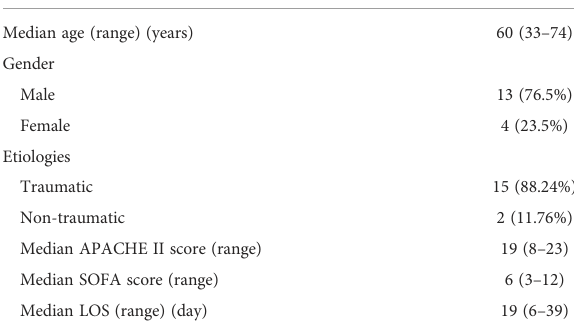
TABLE 1 Demographics and clinical characteristics of 17 patients